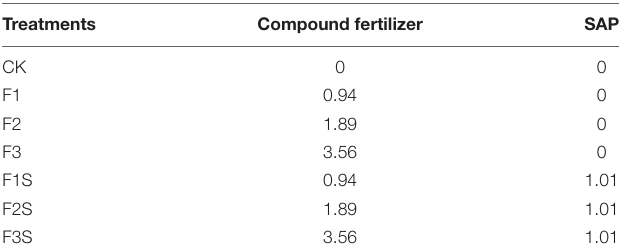
TABLE 1 | Experimental treatments. Treatments Compound fertilizer